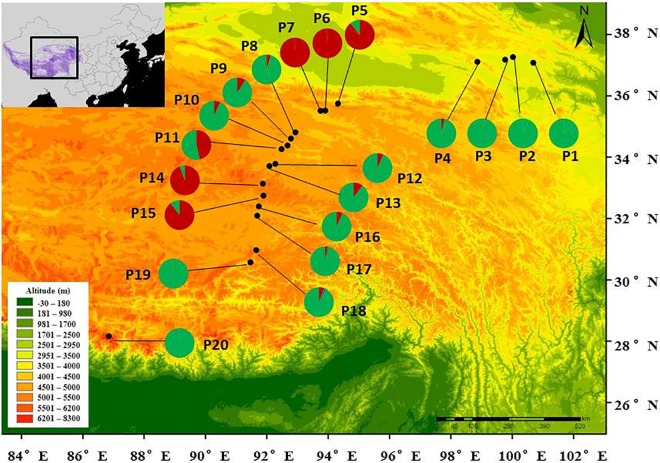
The locations of the 20 sampled Stipa purpurea populations on the Qinghai-Tibet Plateau and their genetic divergence.A heatmap of probability of existence generated by Ecological Niche Modelling is shown as a thumbnail image on the left-top. The pie charts indicate the genetic composition for each population based on the result of a representative STRUCTURE run with K = 2.